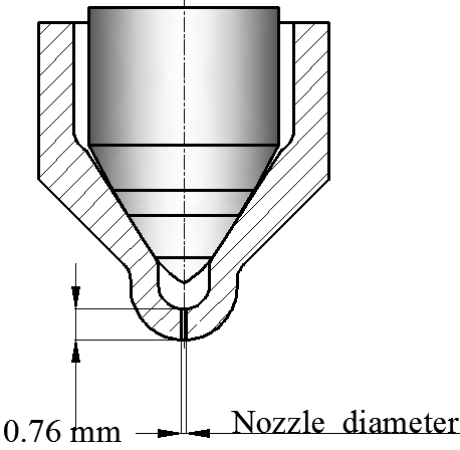
Figure 2. Scheme of the nozzle configuration.